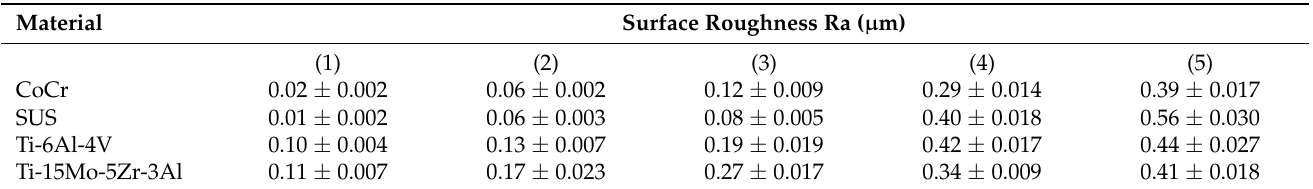
Table 2. Surface roughness of each sample.